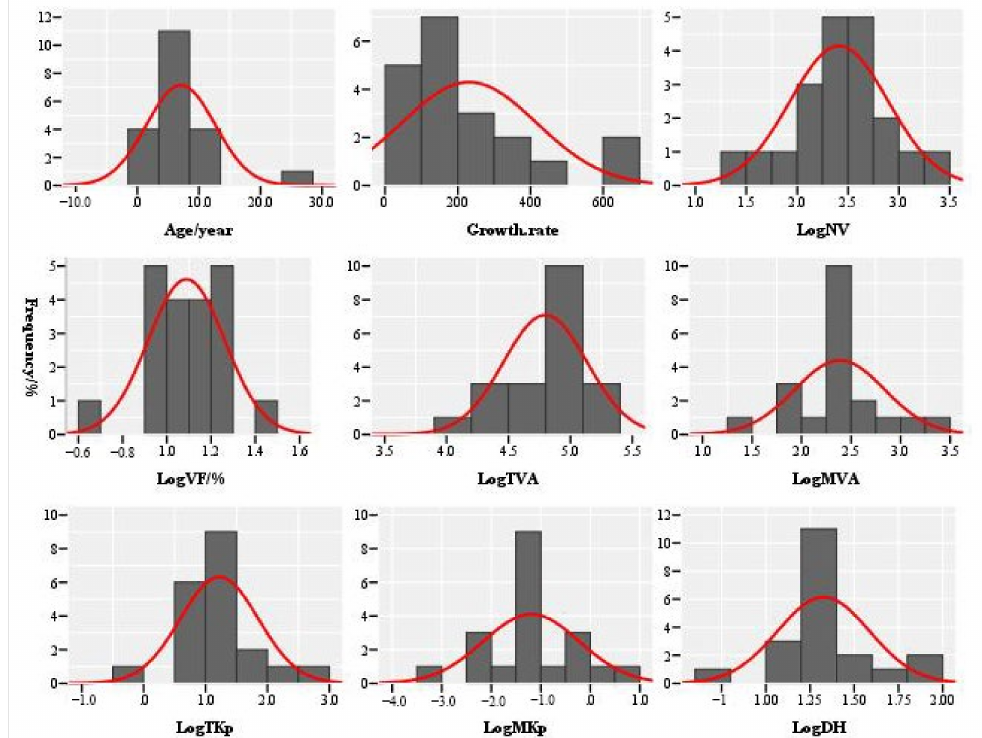
Figure 4. A frequency map of the root vessel characteristics of the Zygophyllaceae plants in China’s arid and semi-arid regions. Age: (year); Growth.rate: ( µ m/year); NV: vessel number; VF: vessel fraction (%); TAV: total vessel area ( µ m 2 ); MVA: mean vessel area ( µ m 2 ); TKp: total water transfer draulic diameter ( µ m). Note: Before the correlation analysis, the original data were converted into